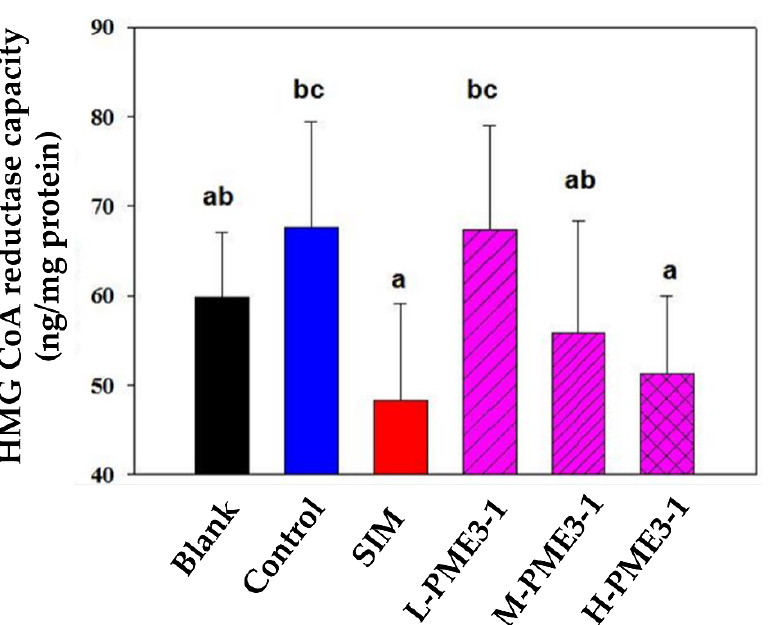
Figure 2. Effects of PME3-1 on HMG-CoA reductase capacity of the liver tissue in high fat and cholesterol diet in hamsters. Each value is expressed as mean ± standard deviation (n = 8). Value (a – c) with different letters within the same row indicate significant difference ( p < 0.05).